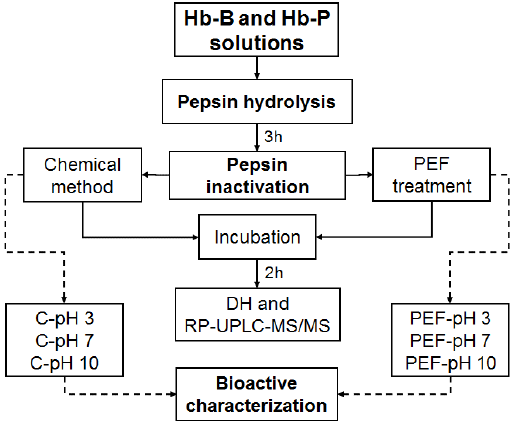
Figure 2. Experimental workflow and analyses (DH: degree of hydrolysis, PEF: pulsed electric fields, Hb-B and Hb-P: bovine and porcine hemoglobin, respectively).